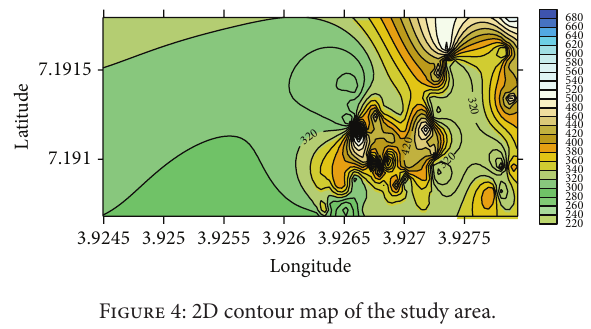
Figure 6: Profile 1.